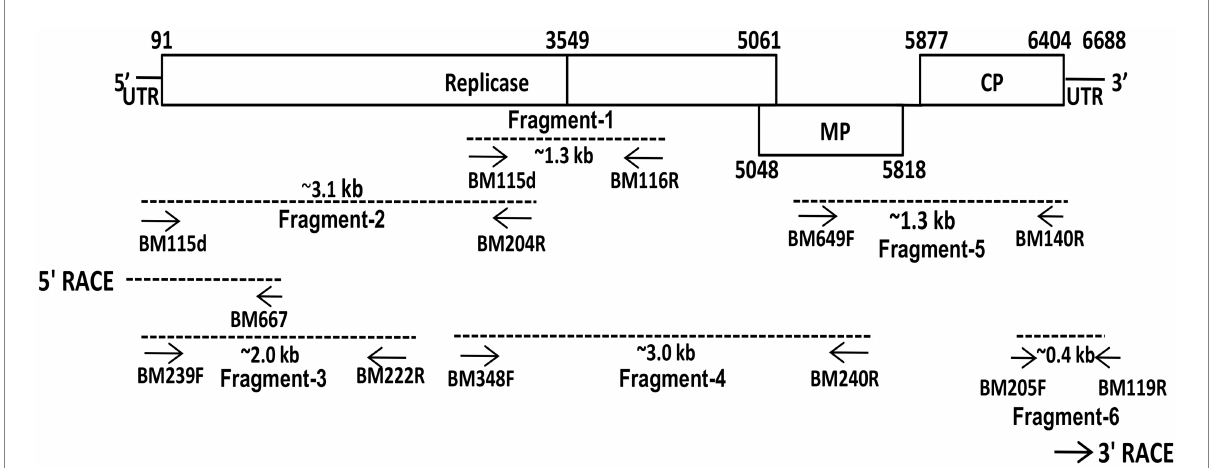
FIGURE 2 Schematic presentation of the strategy used for the amplification of complete genome of plumeria mosaic virus (pluMV-Plu-Ind-1 isolate) infecting Plumeria rubra f. acutifolia . Small arrows indicate the positions of various primers on the genome. The genome segments, which were used for sequencing, are indicated as dotted